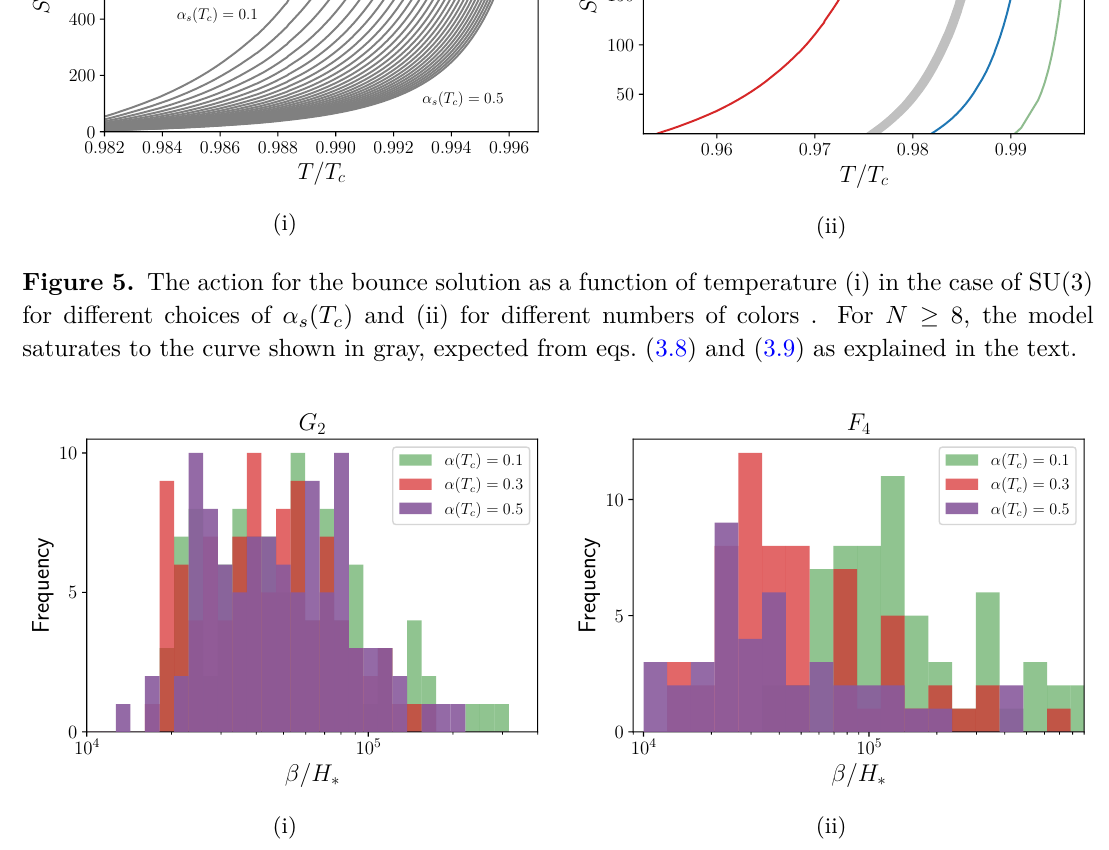
Figure 6. The parameter β giving the inverse duration of the confining PT in the case of G 2 (i) and F 4 (ii). For most effective potentials used in the calculation for both these gauge groups, the result was in the range β/H ∗ ∼ 10 4 − 10 5 , with a similar distribution for the three choices of coupling α ( T c ) = 0 . 1 , 0 . 3 and 0 . 5 for G 2 and a slight dependence of the choice of coupling for F 4